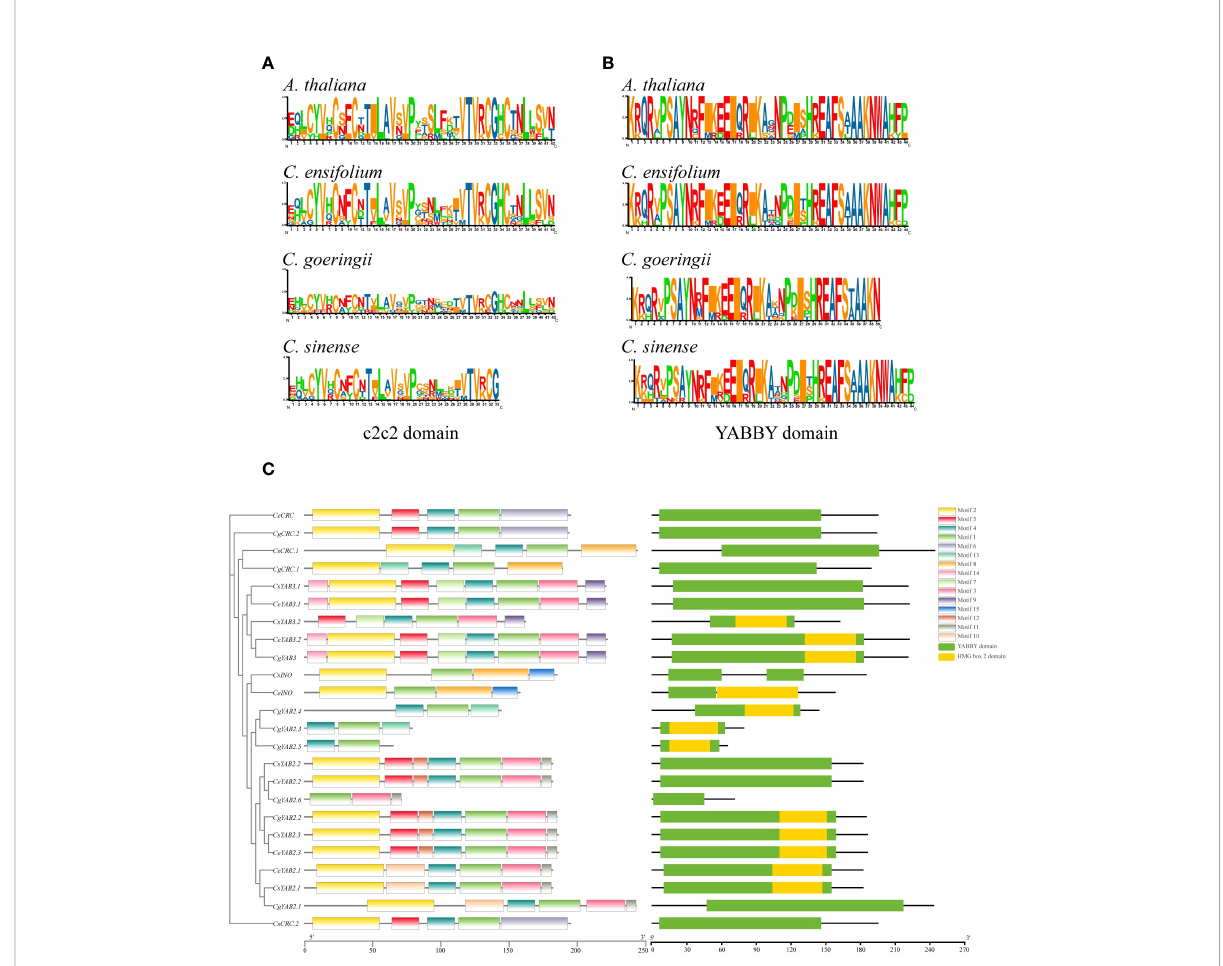
FIGURE 2 Conserved domains from three Cymbidium species and A. thaliana . (A) Sequence logo of the zinc- fi nger domain in the N-terminus. (B) Sequence logo of the YABBY domain in the C-terminus. (C) Motifs and conserved domains in the YABBY protein amino acid sequences in Cymbidium